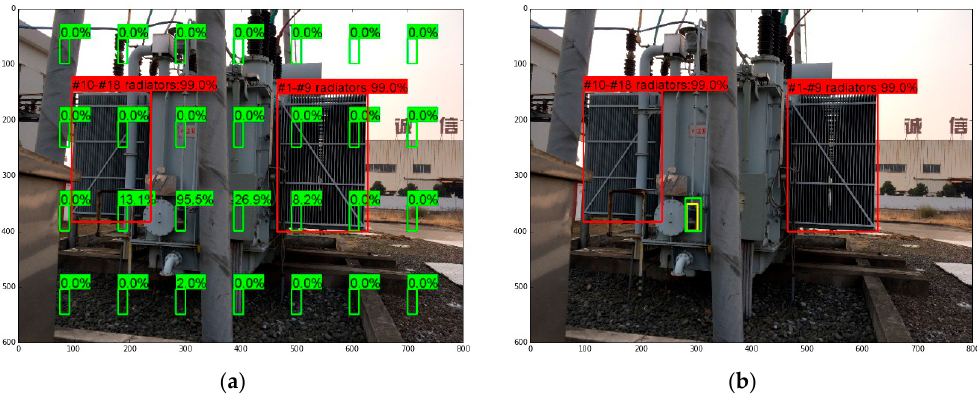
Figure 9. Two examples for illustrating the effect of relative position features. ( a ) The refinement of probabilities; ( b ) The refinement of coordinates.